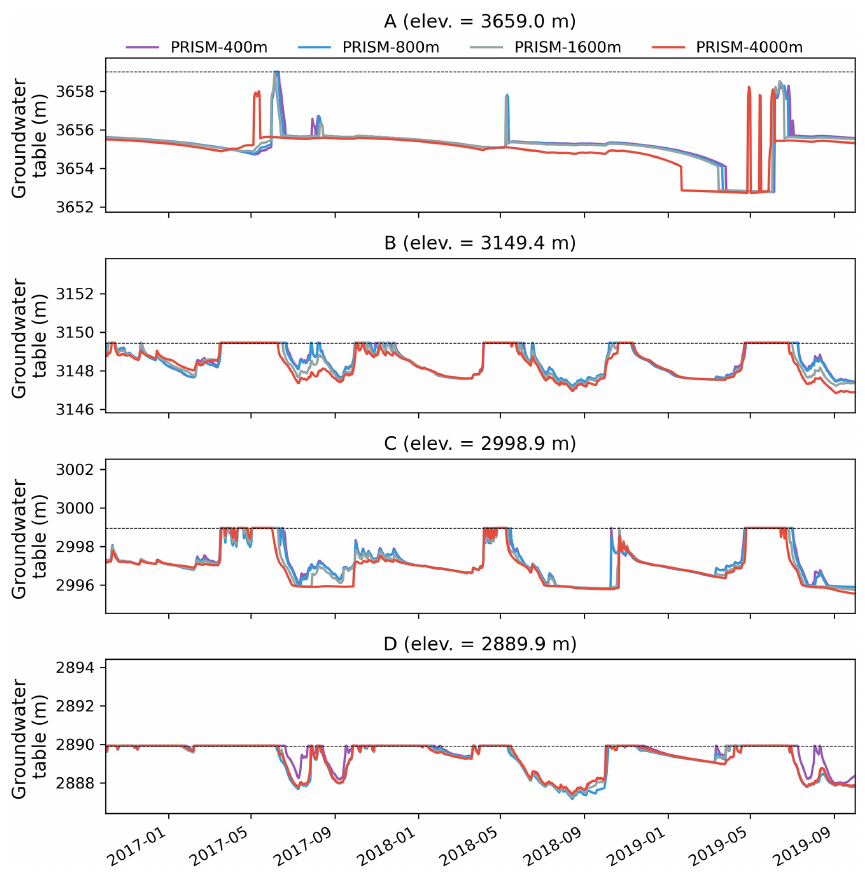
Figure 13. Simulated groundwater table at four selected locations (A–D) under different spatial resolutions of PRISM. Dashed line indicates the surface elevation. Also, see Fig. 1 for location